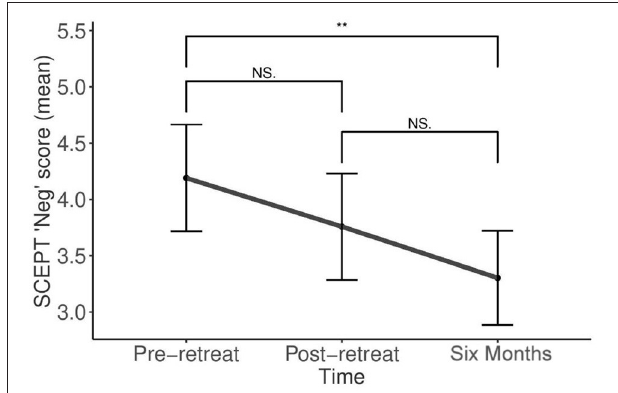
FIGURE 2 | Sentence Completion for Events from the Past Test (SCEPT): Changes in SCEPT negative valanced memory scores over time [NS, non-significant ( P > 0.05), ** p ≤